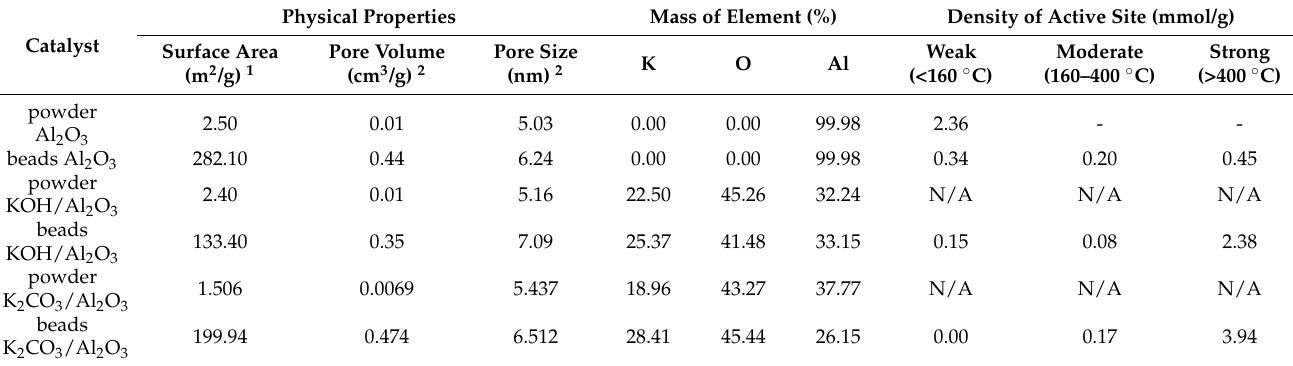
Table 1. Physical properties of alumina-based K 2 CO 3 and KOH catalyst with its mass content and density of active sites.